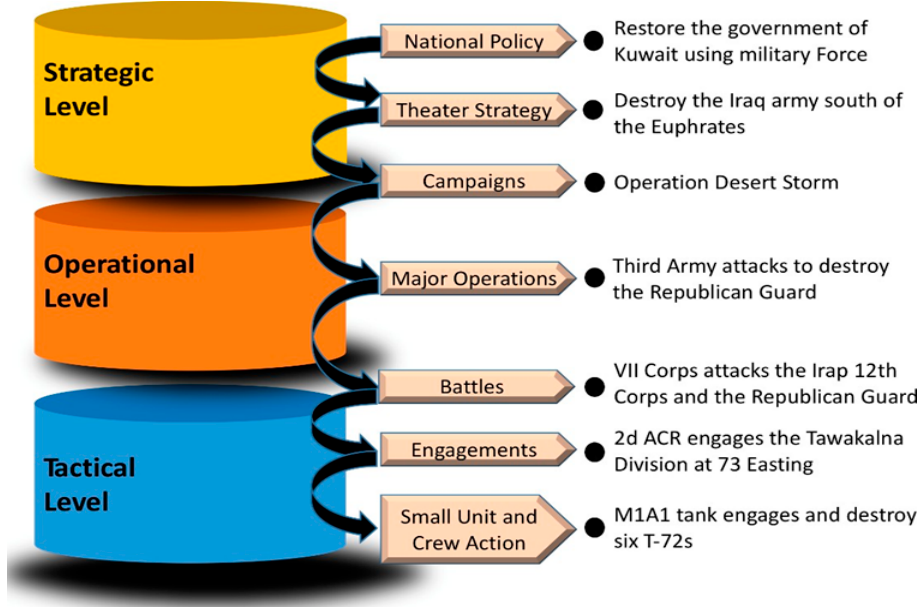
Figure 2. An MRM system to model the decision levels of the military should be hierarchical (modified and adapted from Department of the Army (2008)).